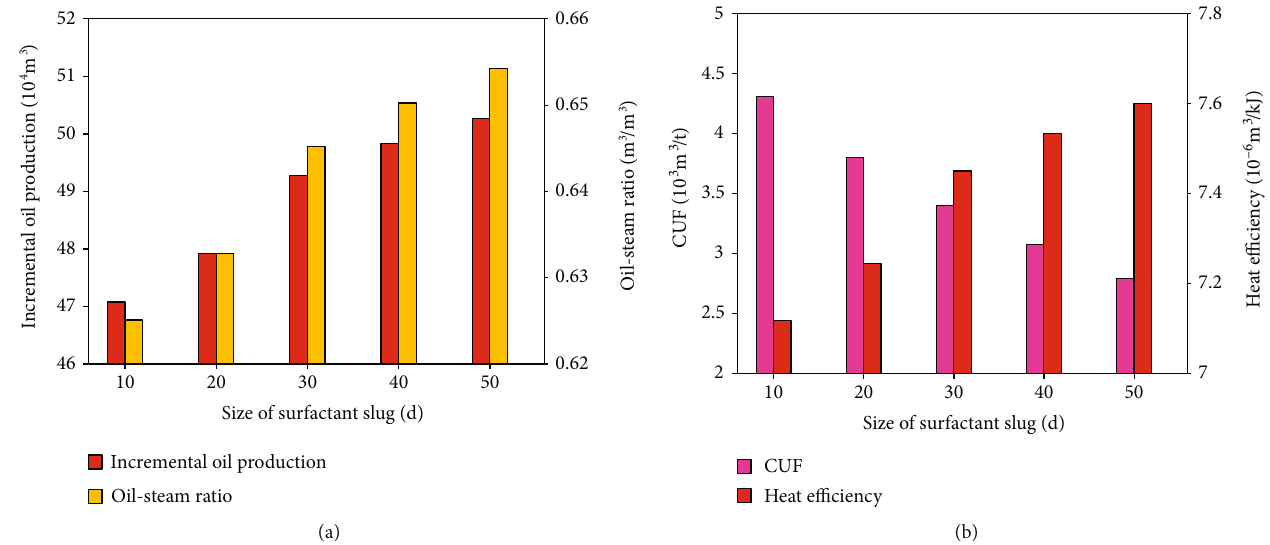
Figure 9: E ff ect of the size of surfactant slug: (a) incremental oil production and oil-steam ratio; (b) CUF and heat e ffi ciency.